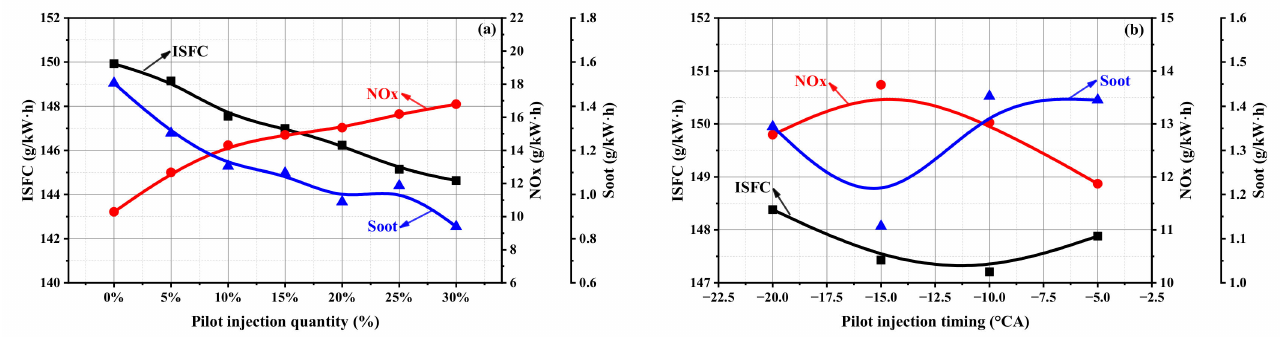
Figure 20. ( a ) The effect of pilot injection quantity on specific fuel consumption, NOx, and soot emission ( b ) The effect of pilot injection timing on specific fuel consumption, NOx, and soot